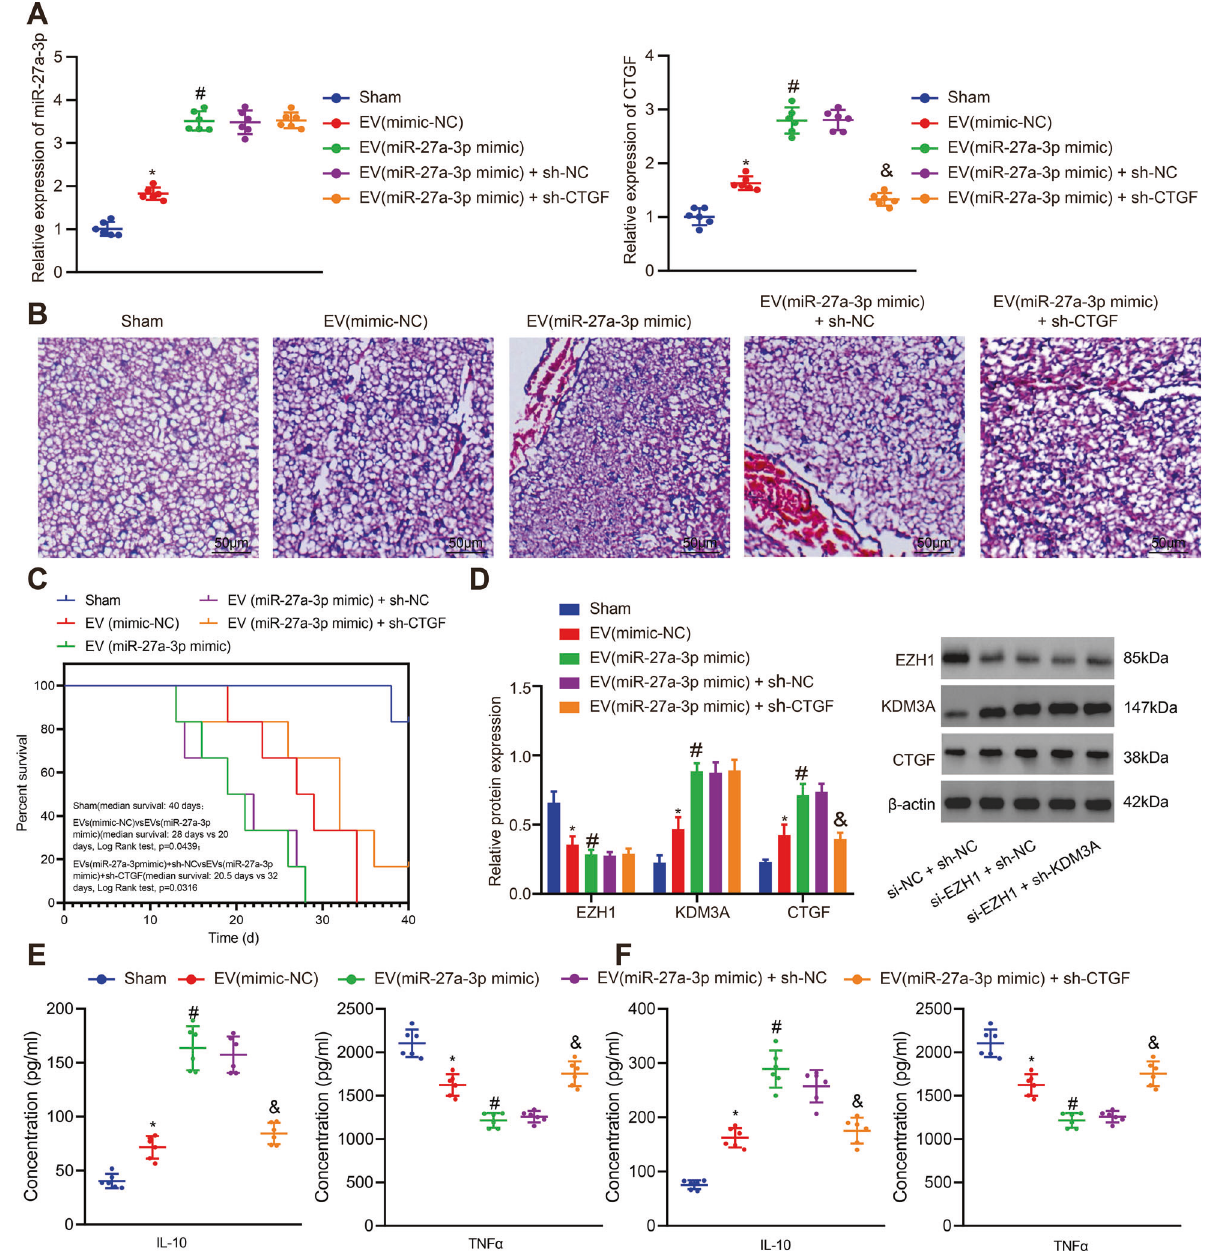
Fig. 7 GBM-EV-derived hsa-miR-27a-3p aggravates GBM in vivo. Nude mice were injected with EVs from GBM cells overexpressing hsa-miR- 27a-3p or/and macrophages transfected with lentivirus-mediated CTGF . A hsa-miR-27a-3p expression and CTGF mRNA expression in each group of mice ( n = 6) determined using RT-qPCR. B H&E staining results of GBM cell invasion to the mouse brain tissues ( n = 6) (scale bar = 50 μ m). C Statistical data of survival time of mice in each group ( n = 6). D Western blot analysis results of the protein expression of EZH1, KDM3A and CTGF in mouse brain tissues of each group ( n = 6). E ELISA results of secretion levels of IL-10 and TNF- α in peripheral serum of mice ( n = 6). F ELISA results of content levels of IL-10 and TNF- α in lysate of mouse tumor xenografts ( n = 6). * p < 0.05 compared with sham- operated mice. # p < 0.05 compared with mice harboring EVs containing mimic-NC. & p < 0.05 compared with mice harboring EVs containing hsa-miR-27a-3p mimic +